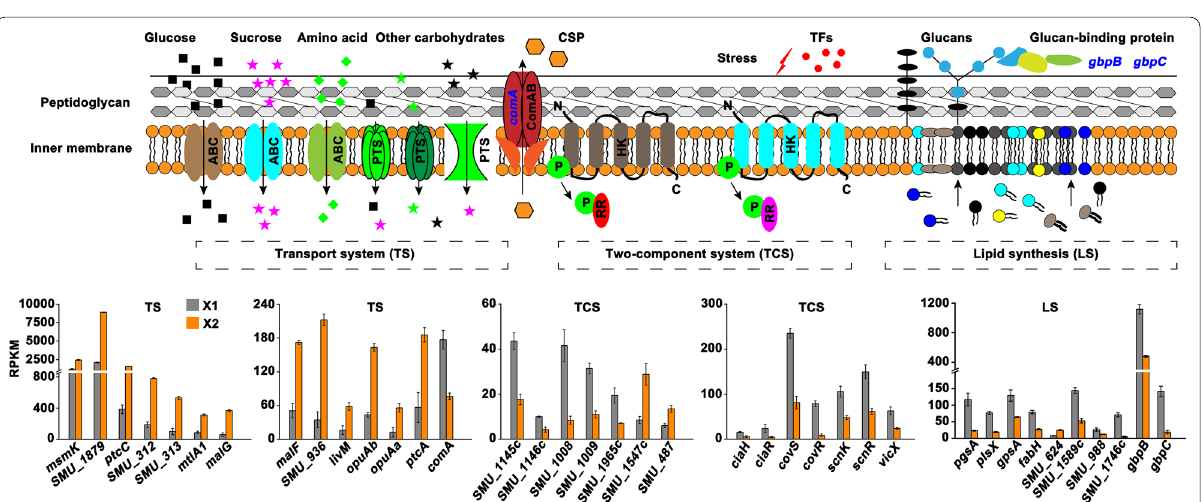
Fig. 7 Changes in the expression of genes involved in transport system, two-component system, and lipid synthesis. Genes colored with blue indicate downregulation. Only part of the genes with a relatively higher fold change were displayed. Expression level shown as RPKM was displayed by mean standard deviation. The detailed information of these DEGs were presented in Additional file 1: Table S1. ABC: ATP-binding ± cassette; PTS: sugar phosphotransferase system; HK: histidine kinase; RR: response regulator; P in green circle indicates phosphoryl group; CSP: competence-stimulating